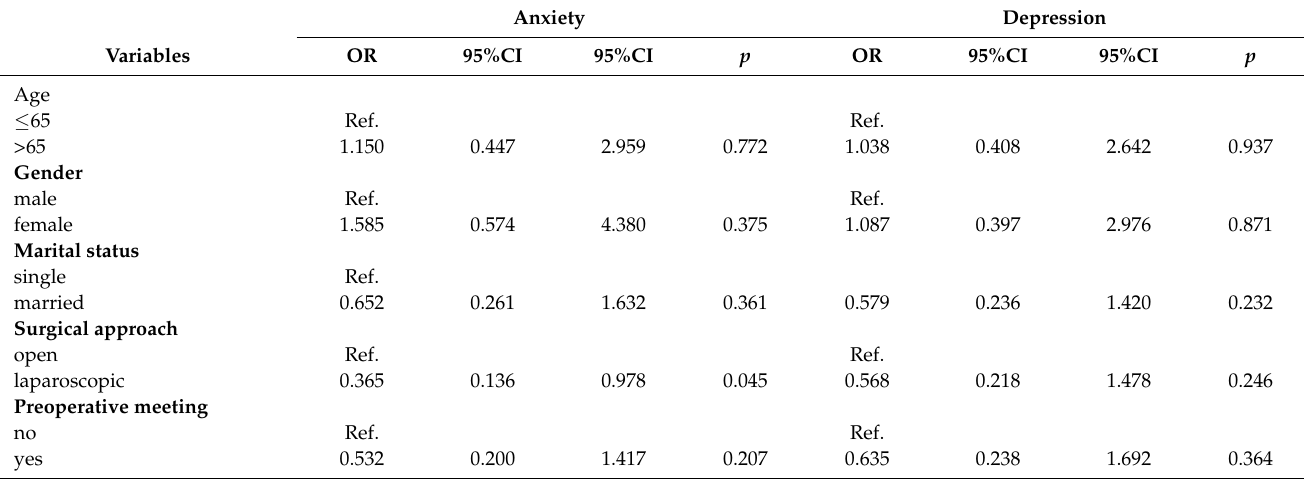
Table 2. Analysis of clinical factors associated with borderline or abnormal preoperative feelings of anxiety and depression in HADS (generalized nonlinear model, multivariate logistic regression).